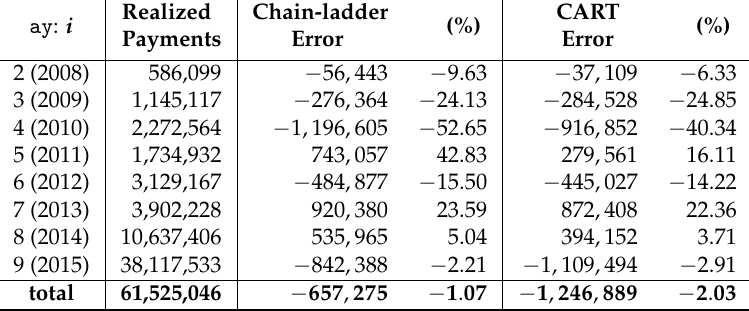
Table 11. Forecast errors of CARTs and chain-ladder method on the next-year claim